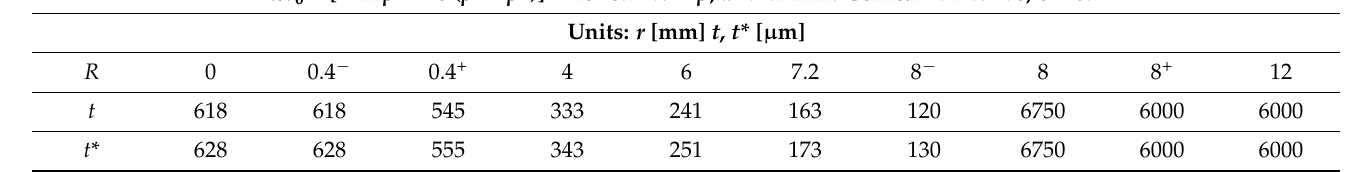
Figure 11. Drawing section, in ( x , z ) plane, of the VCM front part showing the degree ‐ of ‐ freedom (DOF) boundaries. These conditions applies to the previous FEA modeling as blocked , i.e., non ‐ mov ‐ able, in the axial and tangential directions, i.e., z and y and is free to move in the x ‐ direction. The force F = 10 daN is applied over ρ ≤ 0.03125, i.e., 0.25 mm radius area.